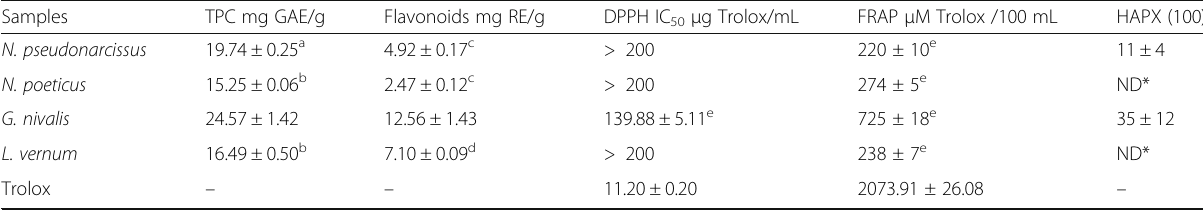
Table 2 Total polyphenolic content (mg/g) and the results of antioxidant activities